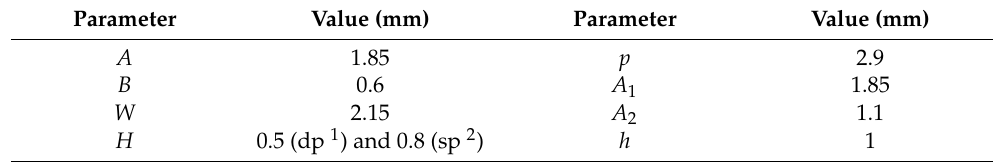
Figure 17. Single periodicity ideal unit cell. ( a ) Perspective, bottom and top views and ( b ) lateral view in glide and non-glide symmetric positions. Periodic in x -direction. Table 2. Values of the parameters used in the design of the unit cells shown in Figures 16 and 17. Parameter Value (mm) Parameter Value